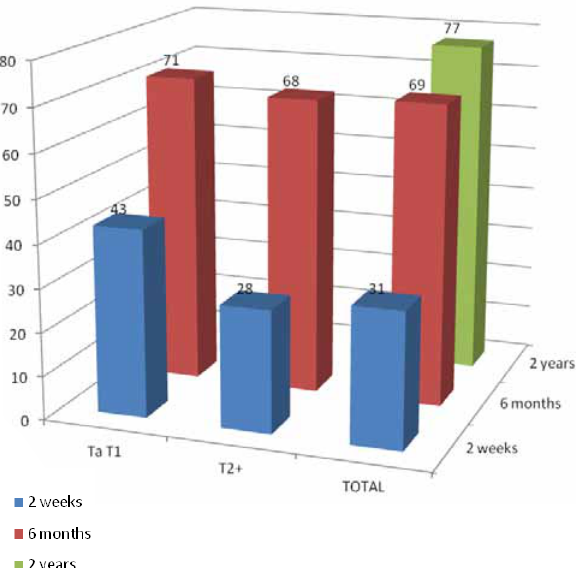
Figure 1 - Results based on tumor stage (initial staging). The rate of relapse is shown in blue, green and red.